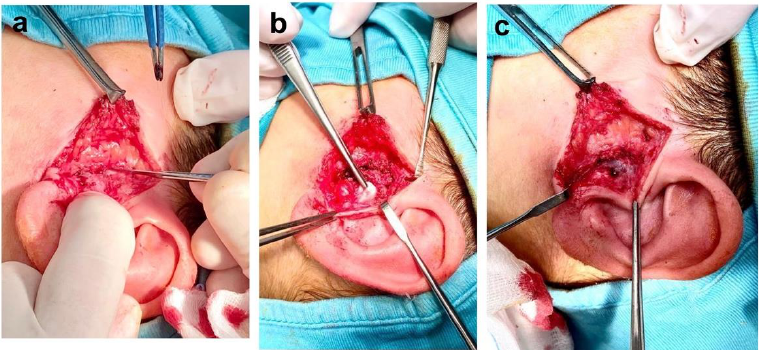
4 of 9 Figure 3. ( a – d ) Axial MRI FLAIR and traditional sequences. * and the white arrows show the mass and its relationship with surrounding tissue. ( e ) Coronal view shows (white interrupted arrows) the relationship of the mass with the parotid fascia and the gland.